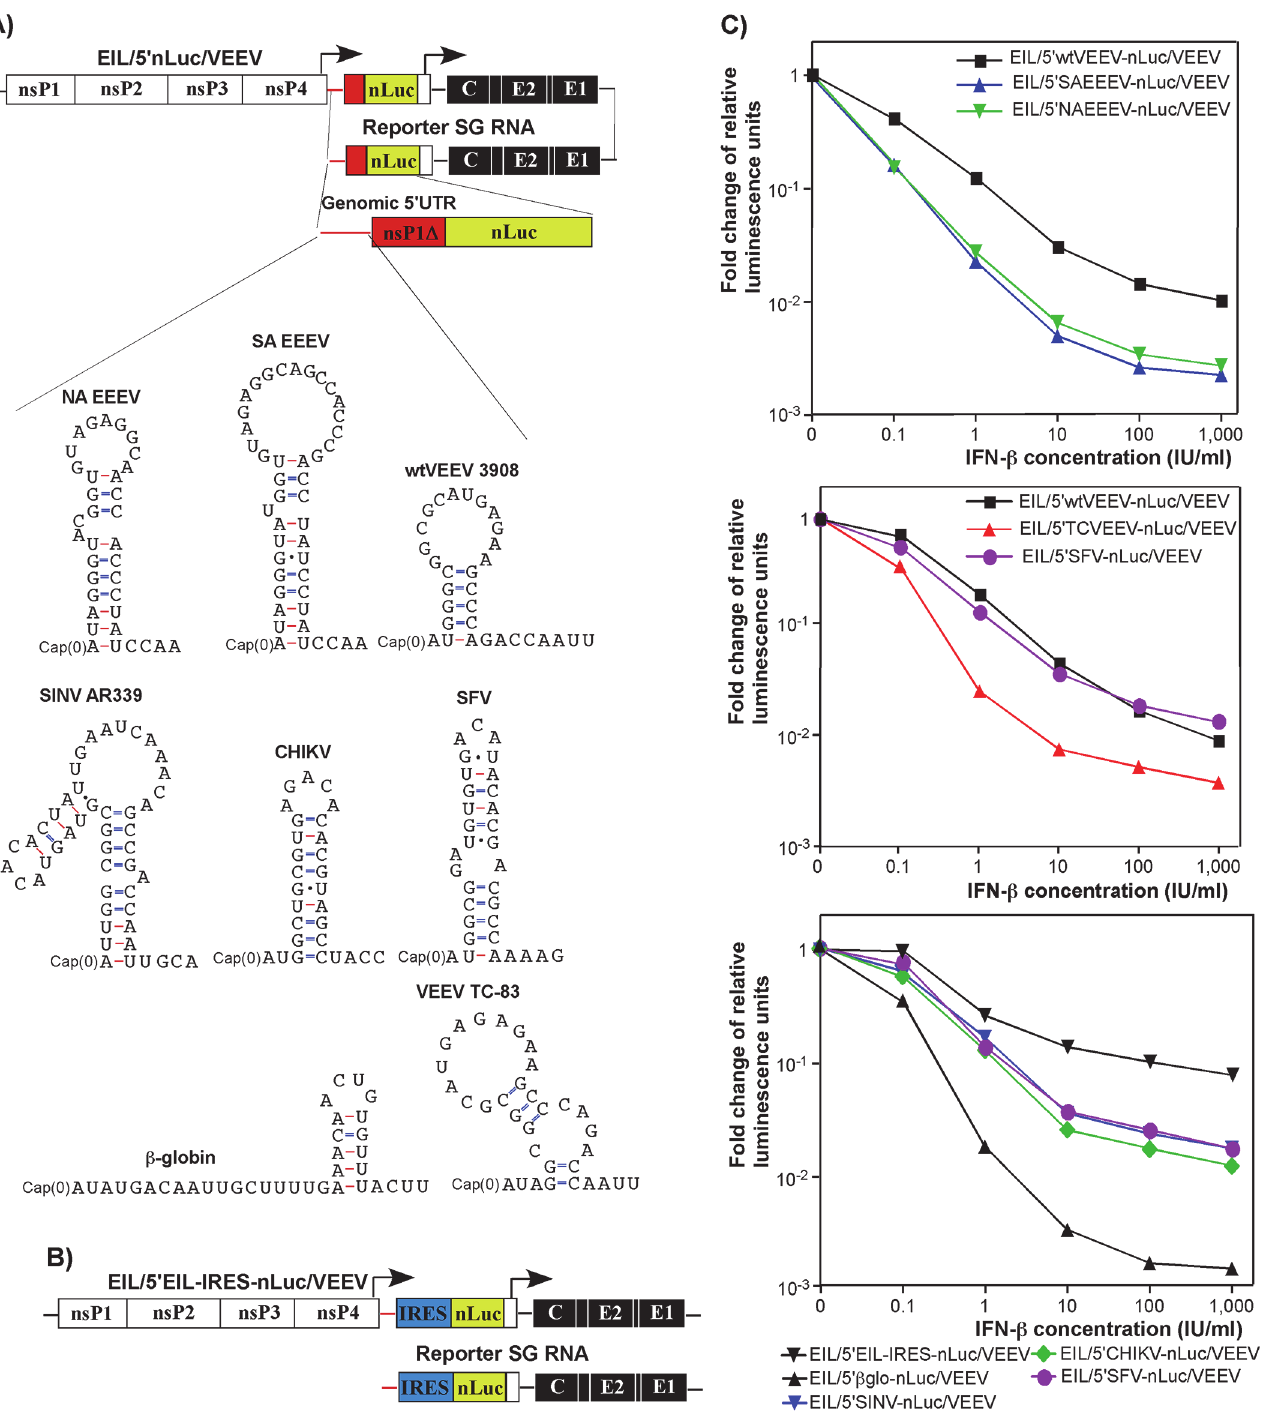
Fig 4. Levels of resistance of alphavirus RNA translation to IFN- β is determined by 5 ’ UTRs of their genomes. (A) The schematic representation of EIL/5 ’ nLuc/VEEV genomes with different 5 ’ UTRs in the nLuc-encoding SG RNAs and the computer predictions (m-Fold) of the RNA foldings. (B) The schematic representation of the EIL/5 ’ EIL-IRES-nLuc/VEEV genome, containing EMCV IRES downstream of the EILV SG RNA-specific 5 ’ UTR. Because of the IRES presence, nLuc is likely translated from both viral genome and SG RNA. (C) wt MEFs were treated for 20 h with different concentrations of IFN- β or remained mock-treated and then infected with the indicated viruses for 1 h at 37°C. The MOI used was adjusted for each virus to obtain similar nLuc activity in the mock-treated samples. After infection, cells were incubated in complete medium at 37°C, and nLuc activity was assessed at 4 h post infection. The results were normalized to the nLuc activity in the samples of mock-treated, infected cells. The experiments were repeated multiple times with reproducible